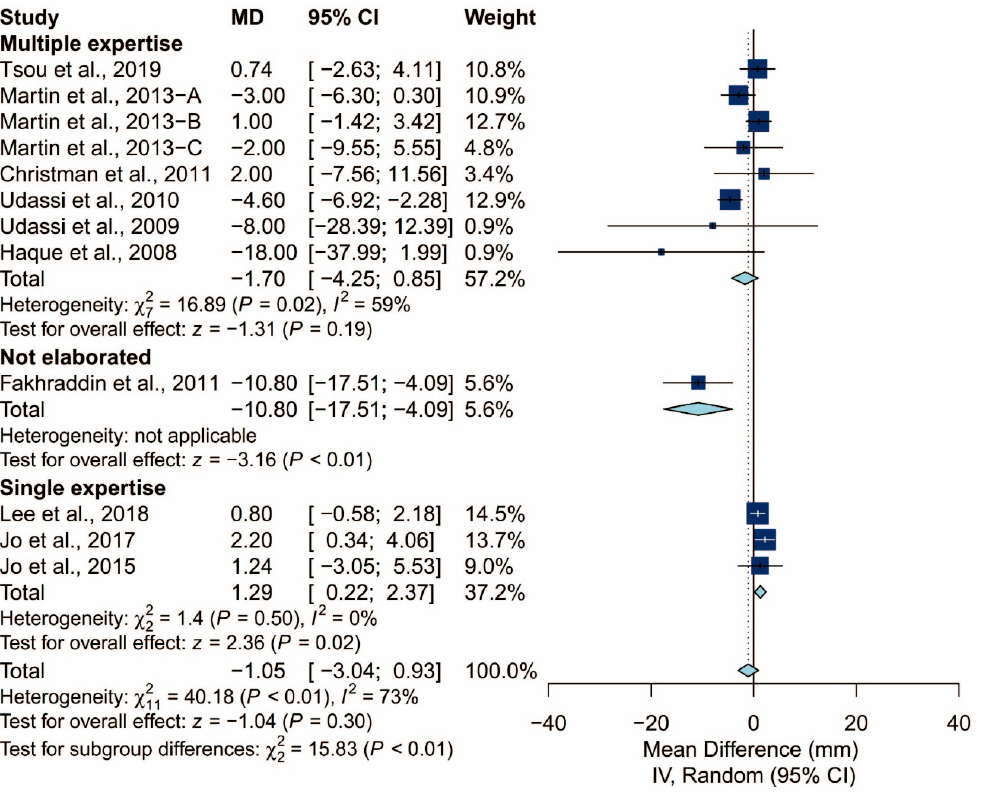
Figure 9. Subgroup analysis of chest compression rate grouped by manikin model.